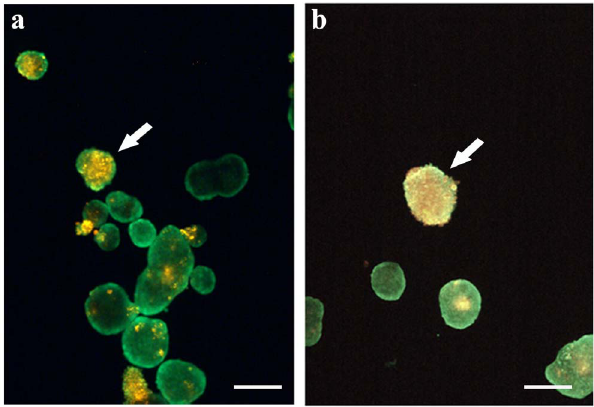
Figure 1. MSC adhesion to pancreatic islets. MSCs previously stained with the red vital fluorescent dye DiI were directly added to green calcein-stained floating pancreatic islets. Attached MSCs are clearly visible as yellow spots (arrows) on green pancreatic islets after 1 week of culture (a) as well as after 4 weeks (b). In green: calcein stained pancreatic islets. In red: DiI stained MSCs. Bar 150 m